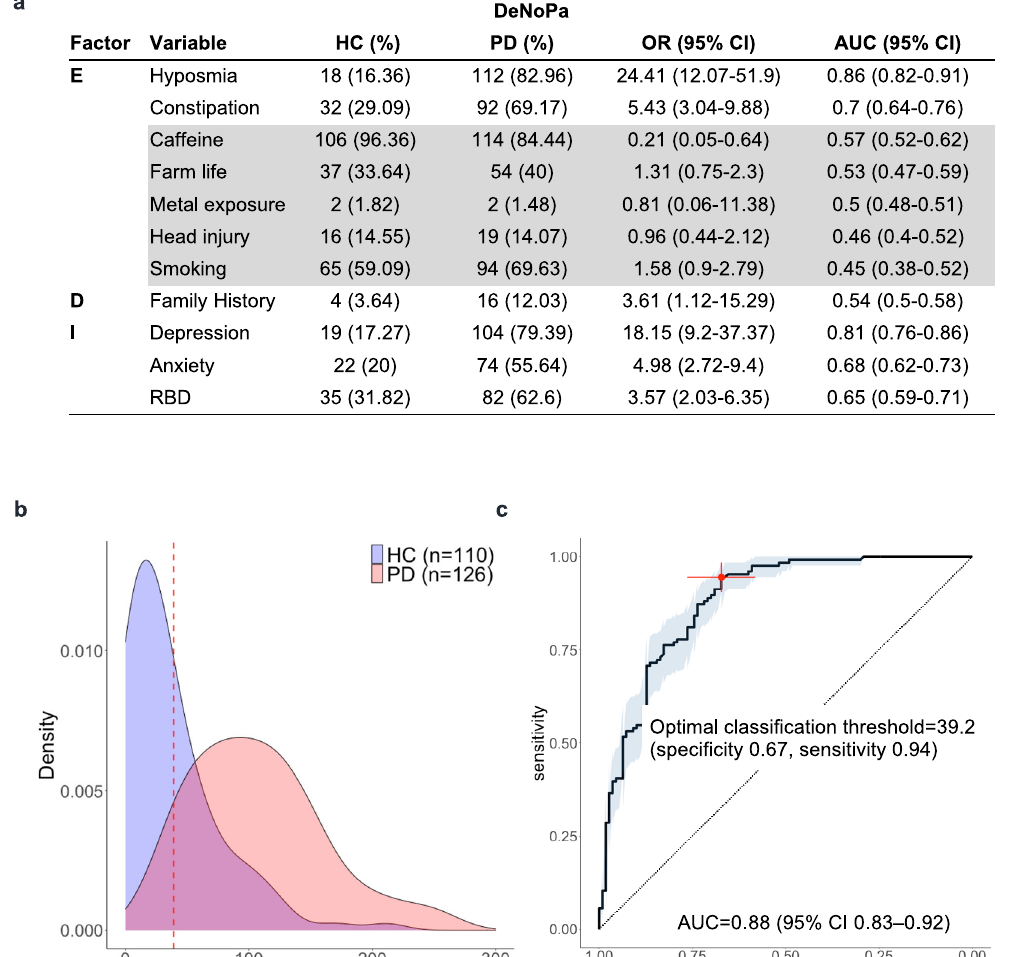
Published in partnership with the Parkinson ’ s Foundation npj Parkinson’s Disease (2022)